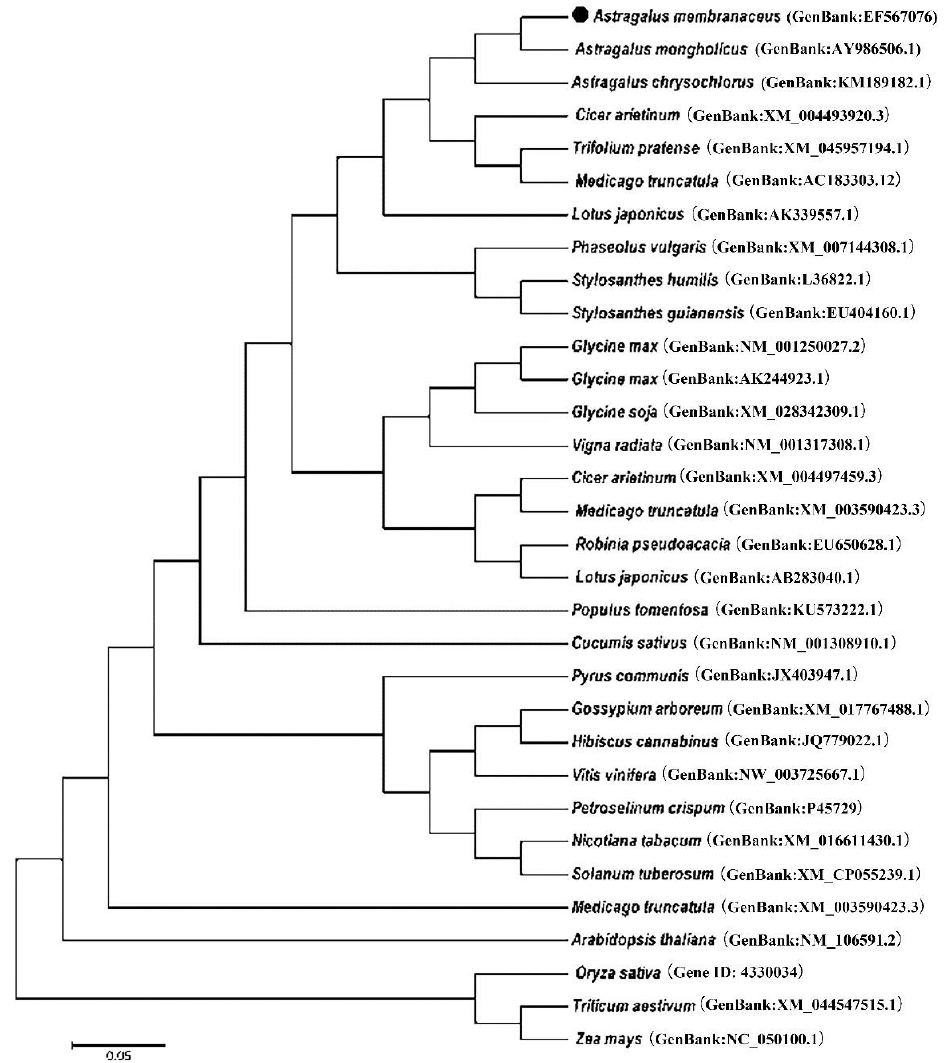
Figure 1. Phylogenetic analysis of PAL protein sequences from different plant species. The Am PAL is highlighted (with a dot). The scale bar represents an estimated sequence divergence of 5%.